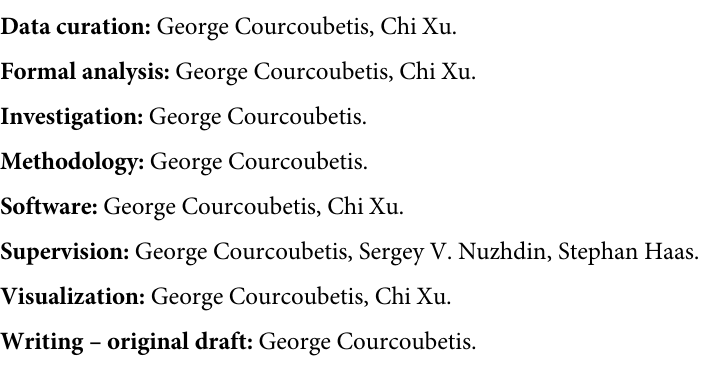
S9 Fig. Uniform growth case: Avalanches in hexagonal and soft cellular networks. By Incre- mentally decreasing the bulk tension in the system, in accordance with (32), the tissue struc- ture goes through a phase transition, from a hexagonal network to a soft network phase. We find the transition point from hexagonal network to soft network is -0.33. If the tension is larger than this value, the tissue lies in the hexagonal network phase, otherwise it is in the soft network phase, with larger cell area and sharp shaped cells. A) Tissue area vs time. B) Cell area vs time. C) Zoomed in plot of tissue area vs time (Soft network) D) Zoomed in plot of cell area vs time (Soft network). We find that the avalanches are absent when transitioning to the soft network, as expected because cells become easily deformable and prevent proliferative stress buildup in the soft network